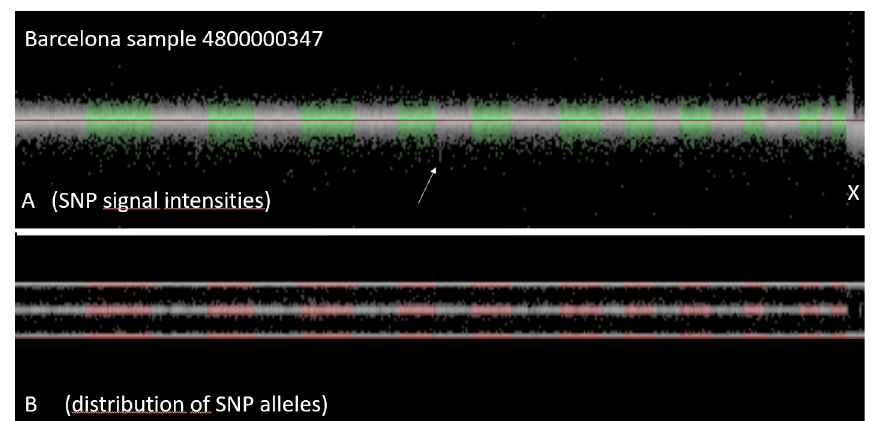
man: the signal intensity of X-chromosomal SNPs is reduced (i.e. there is only one copy of the X-chromosome, compared to two copies of the autosomes. As there is only one X, there are no heterozygous SNPs. As a consequence, the mid-line of the allelic distribution (representing the heterozygous SNPs) is empty.